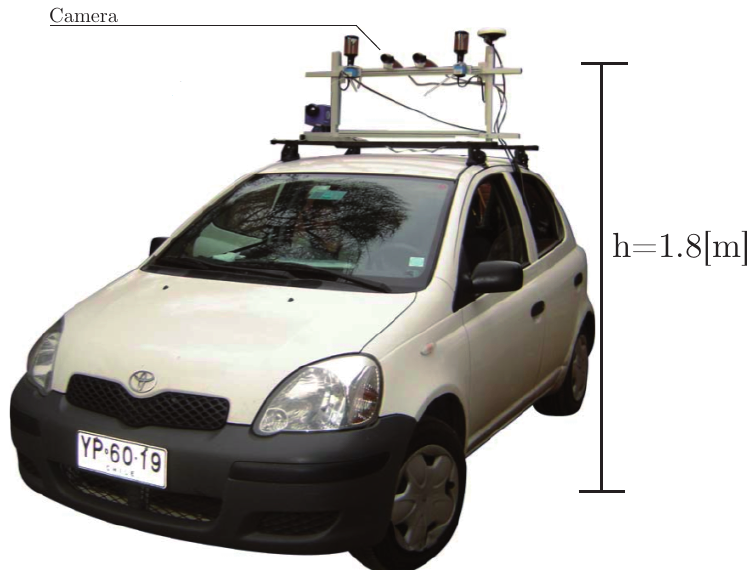
Figure 9. Vehicle for data